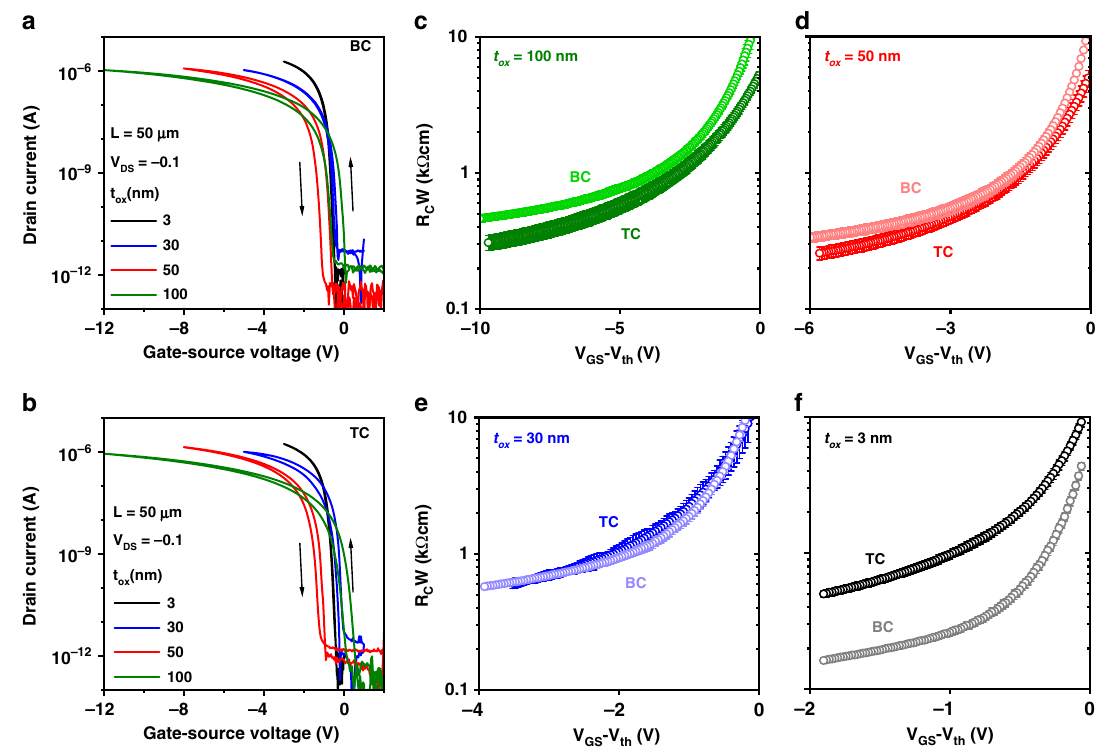
Fig. 3 Bottom-contact and top-contact DPh-DNTT TFTs with different gate-dielectric thicknesses. The TFTs have gate-oxide thicknesses ( t ox ) of 3, 30, 50, and 100 nm, a channel length of 50 µ m, and a channel width of 200 µ m. a , b Transfer characteristics measured in the linear regime of operation ( V DS = − 0.1 V). c – f Channel-width-normalized contact resistance ( R C W ) of TFTs with channel lengths ranging from 6 to 50 µ m extracted in the linear regime of operation ( V DS = − 0.1 V) and plotted as a function of the gate-overdrive voltage ( V GS − V th ), showing the in fl uence of the gate-dielectric thickness on the contact resistance. For the smallest gate-oxide thickness of 3 nm, the contact resistance of the bottom-contact (BC) TFTs is smaller than that of the top-contact (TC)